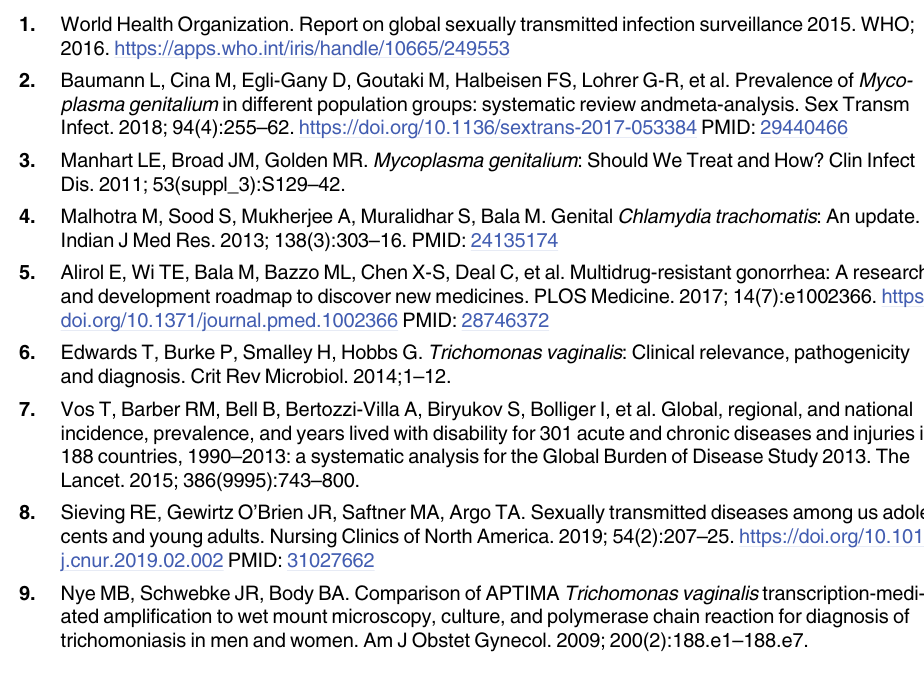
S1 Table. Details regarding the number of positive and negative samples identified with Aptima 1 and Allplex ™